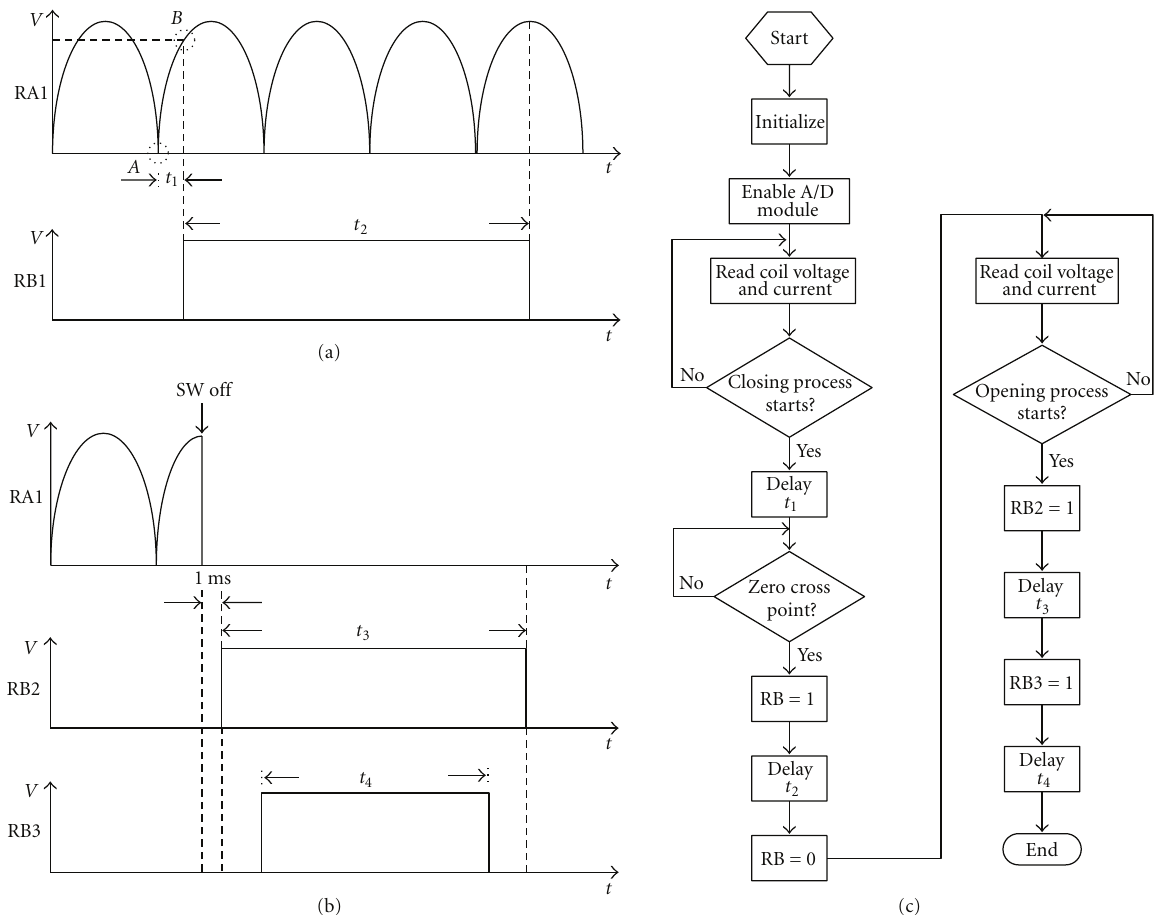
Figure 9: For AC PM contactor (a) command sequences during the closing process (b) command sequences during the opening process, and (c) flow chart of microcontroller